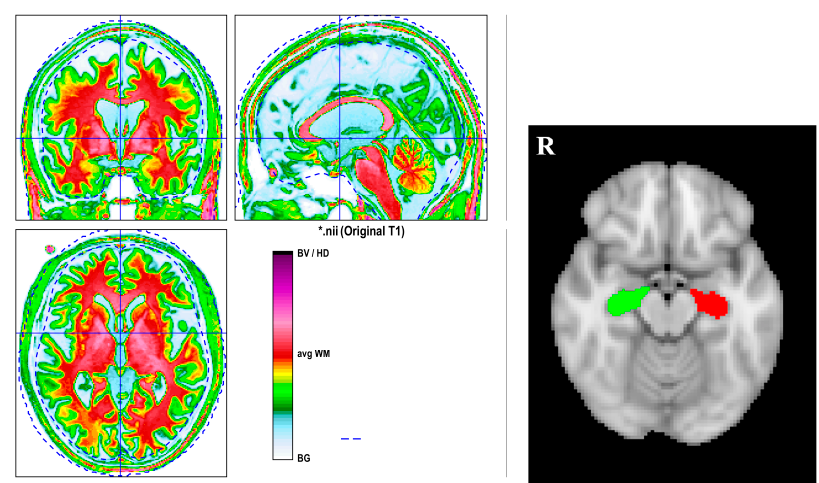
Figure 1. The left side figure is the segmentation result of a subject. The right side figure is the hippocampal ROI from CAT12. The computational anatomy toolbox, version 12.6 (CAT12), was applied to 3D T1-MPRAGE images to perform the brain segmentation. BG = background, CSF = cerebrospinal fluid, CGM = cortical GM, GM = grey matter, WM = white matter. The red color indicates WM; the green color denotes GM; and the yellow color represents the interface between WM and GM. * just represents the name of the subjects.